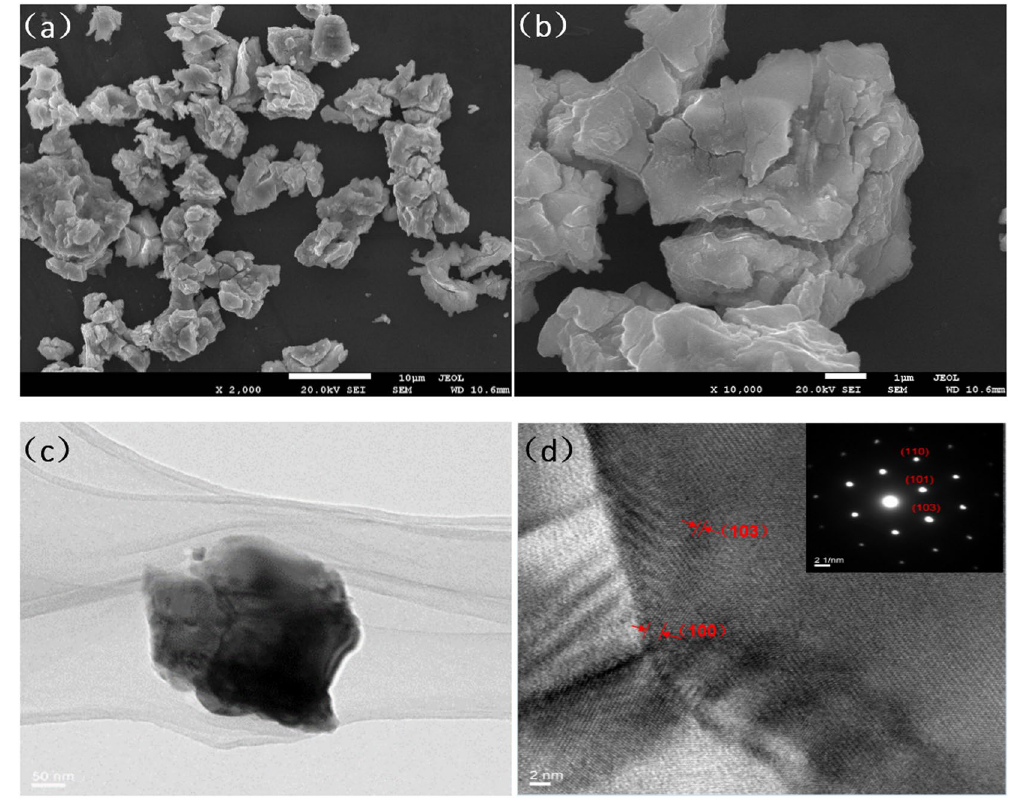
Figure 2. SEM and TEM analyses of the ZrP sample. ( a ) and ( b ) SEM images of the ZrP sample ( c ) TEM images of the as-prepared ZrP ( d ) HRTEM images of the as-prepared ZrP. Inset to ( d ) is the electron-diffraction